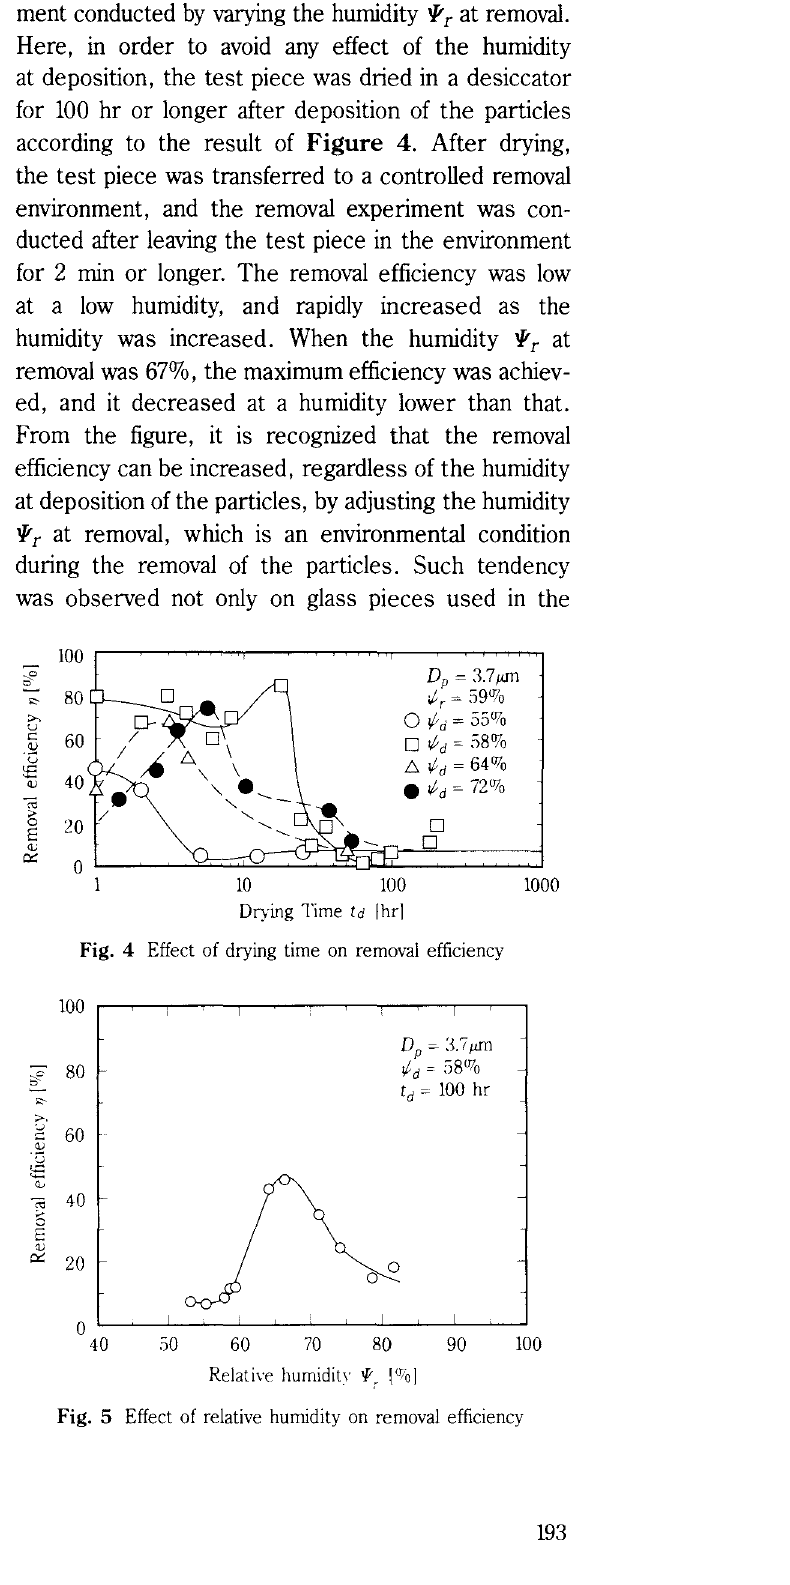
Fig. 5 Effect of relative humidity on removal